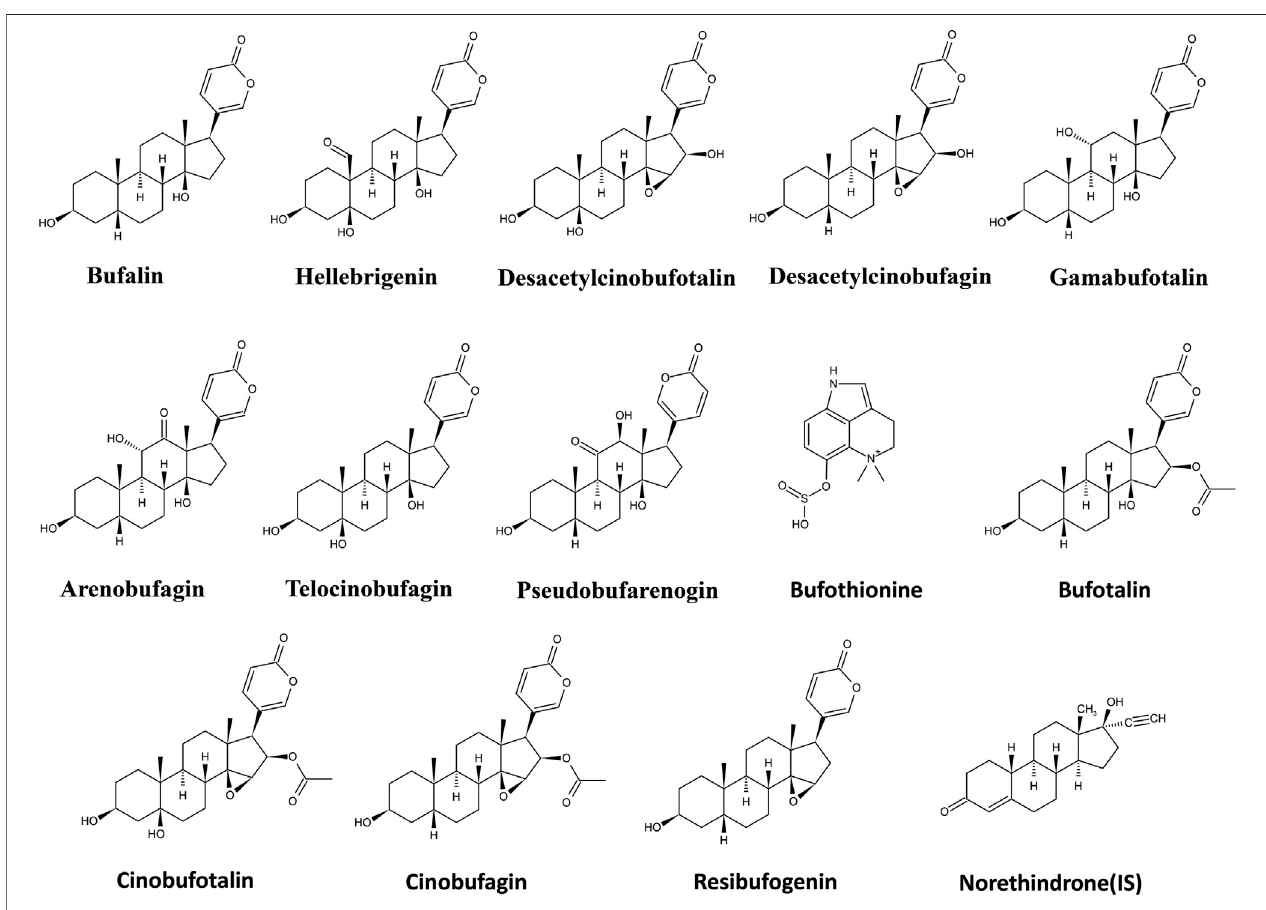
FIGURE 1 | Chemical structures of 13 analytes in cinobufacini and internal standards (IS).